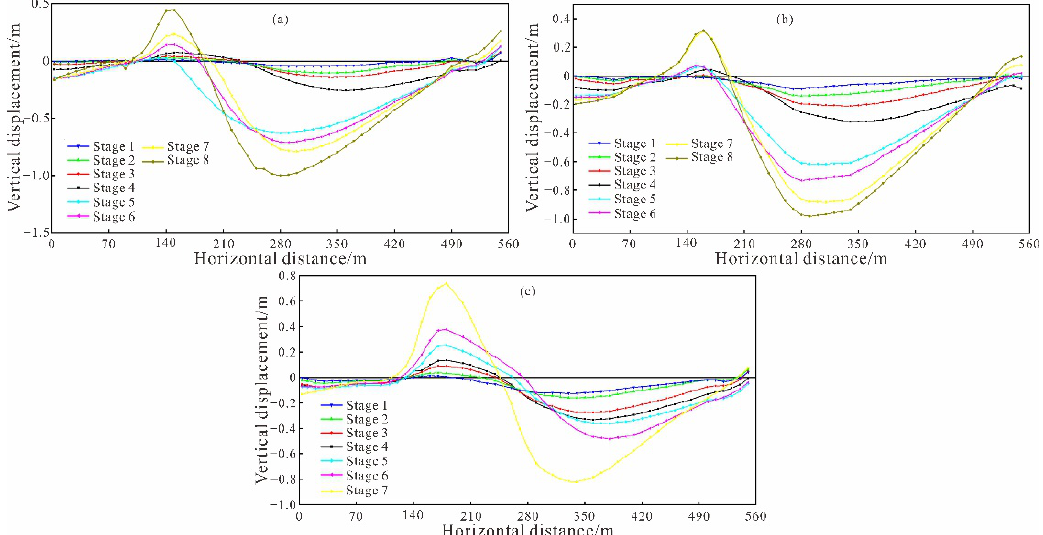
Figure 9. Surface vertical displacement of an ore body with different thicknesses. ( a ) Thickness of 20 m; ( b ) thickness of 40 m; ( c ) thickness of 60 m.